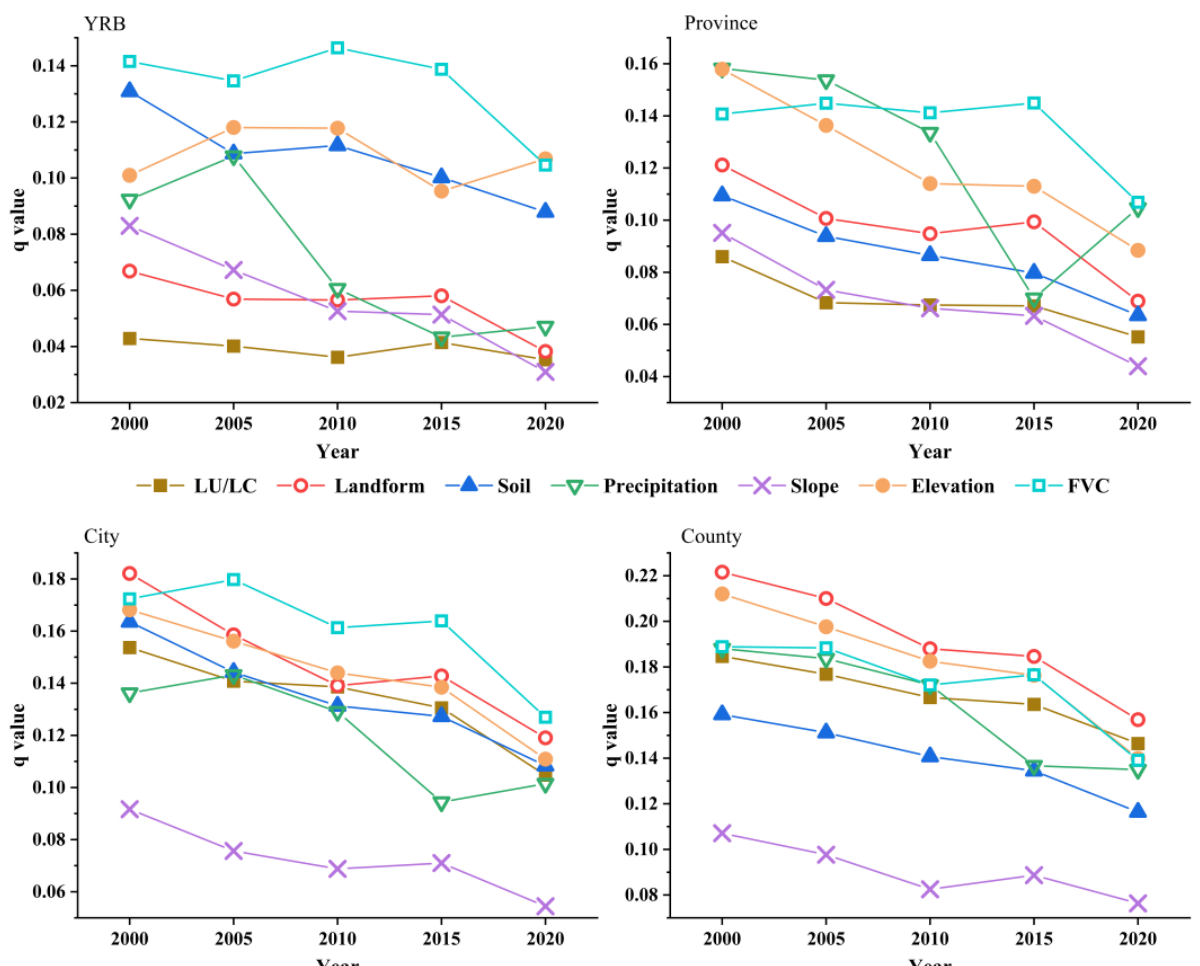
Figure 5. Factor detection results from 2000 to 2020.